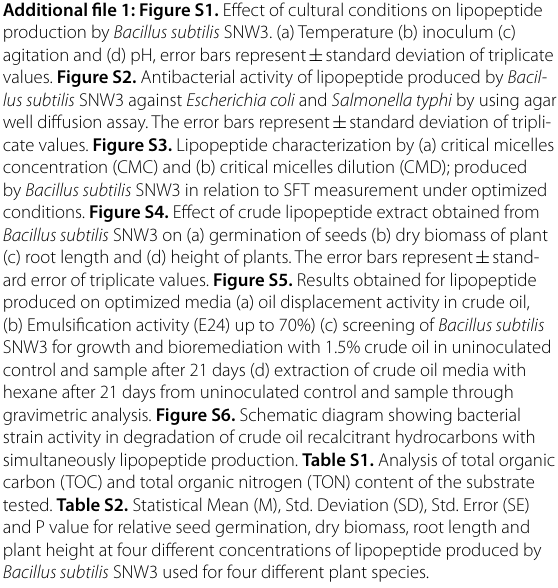
carbon (TOC) and total organic nitrogen (TON) content of the substrate tested. Table S2. Statistical Mean (M), Std. Deviation (SD), Std. Error (SE)